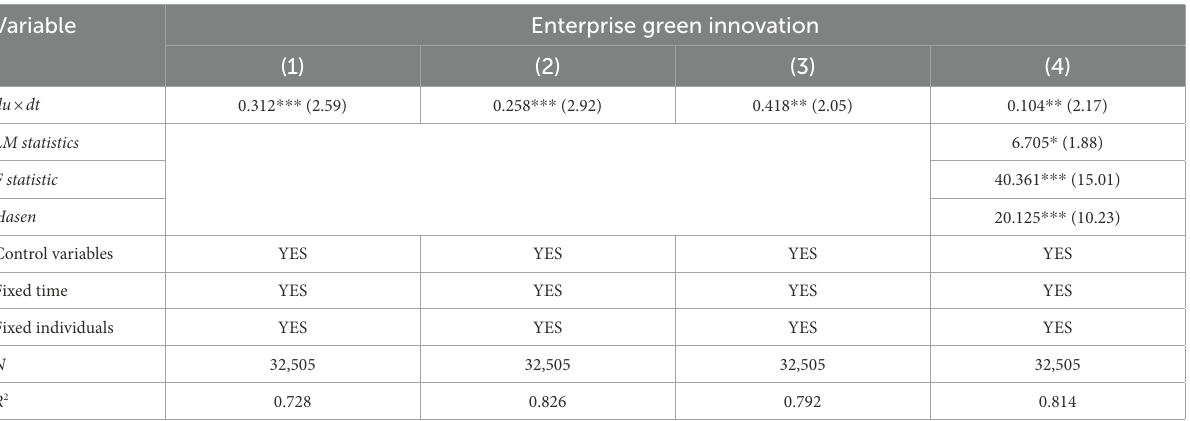
TABLE 3 Robustness test and endogenous regression results.